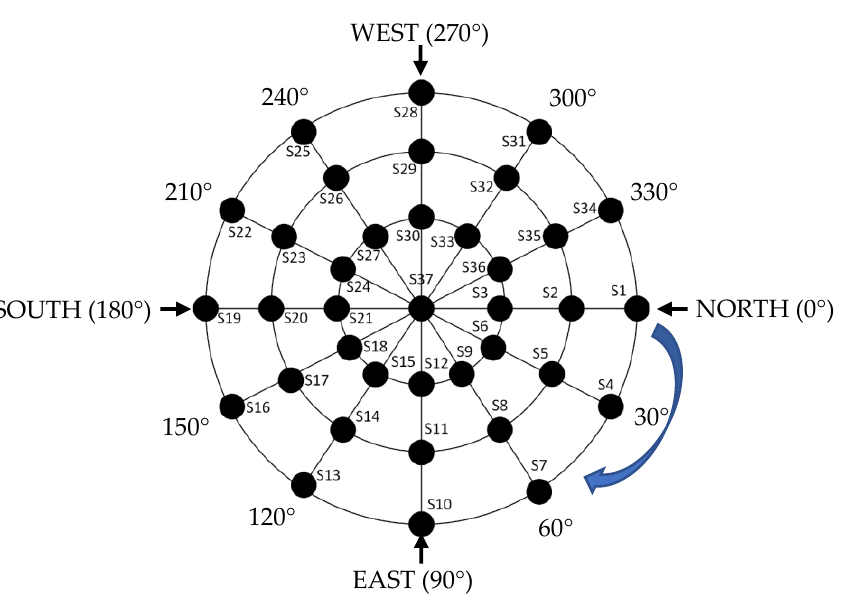
Figure 5. Top view of the locations of 37 light sensors.